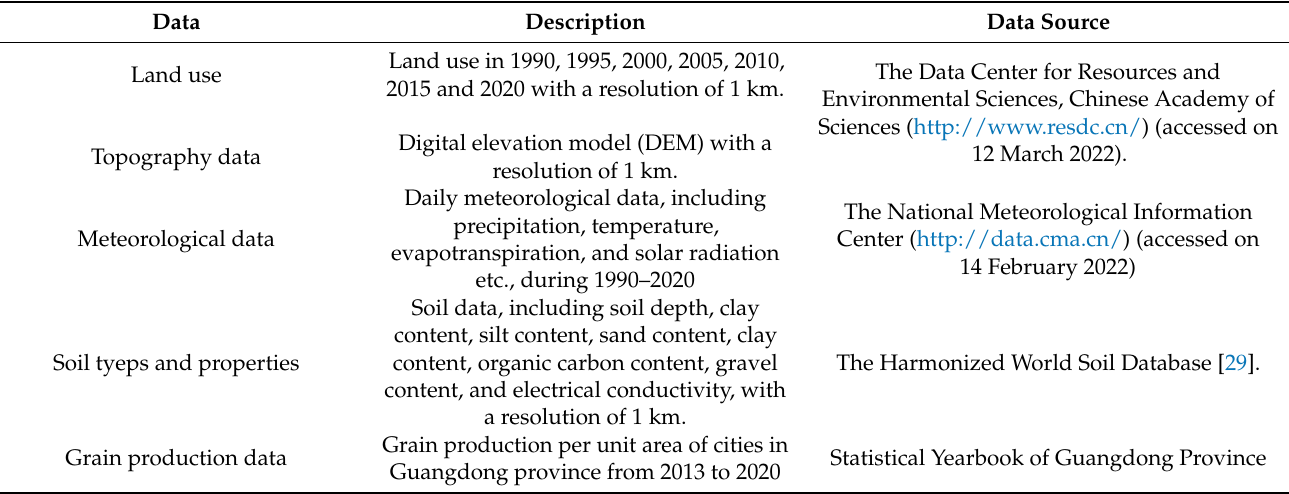
Table 1. Input data for ecosystem services assessment in Guangdong province.